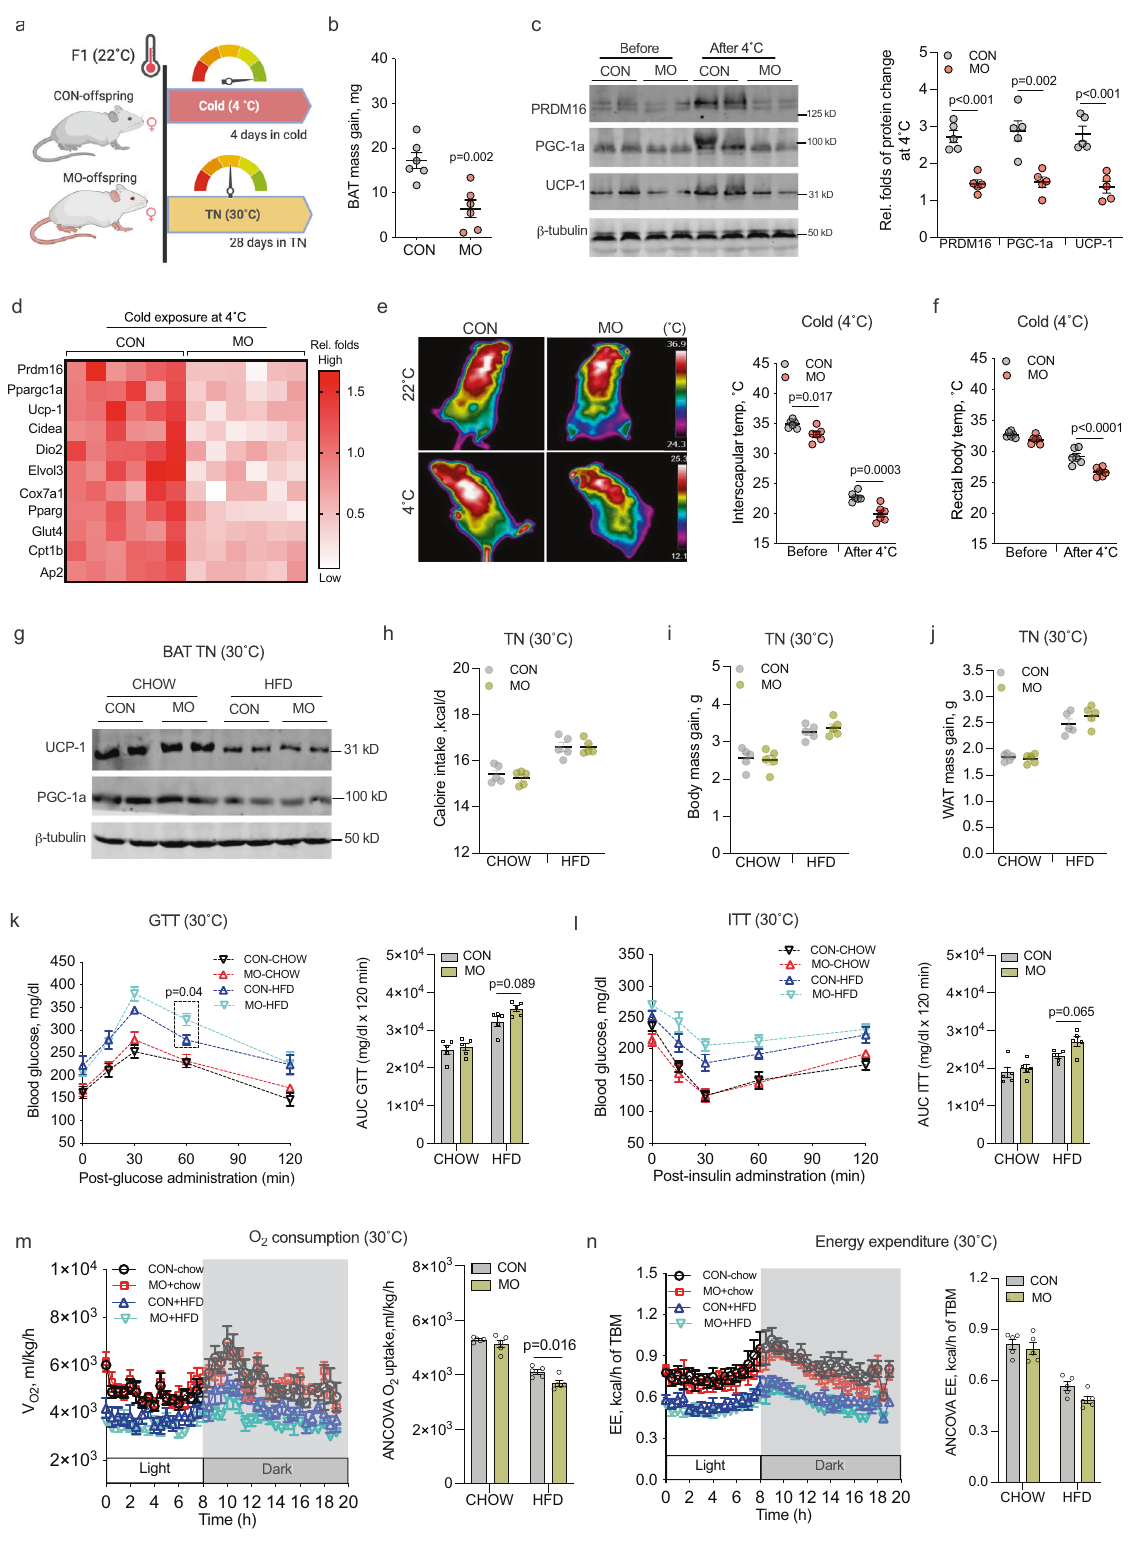
abolished the difference in glucose, insulin sensitivity, oxygen consumption, and energy expenditure between control and MO female offspring (Fig. 2k – n and Supplemental Fig. 4g, h). Taken together, these data showed that impairment of BAT thermo- genesis mainly accounts for reduced energy expenditure and